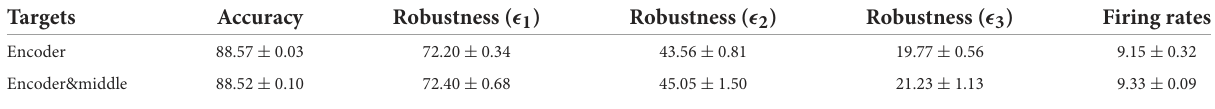
TABLE 5 Comparison of attention targets on CIFAR-10 (%).